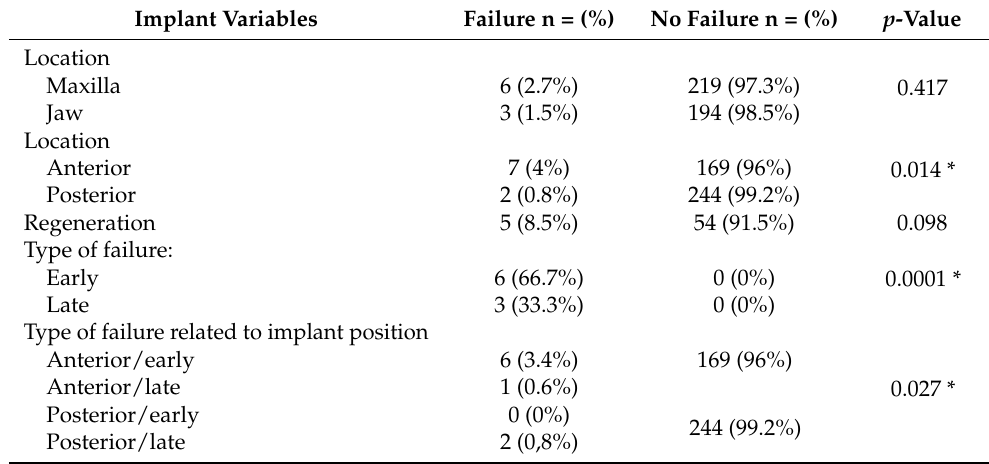
Table 6. Association between implant location, regeneration, and type of implant